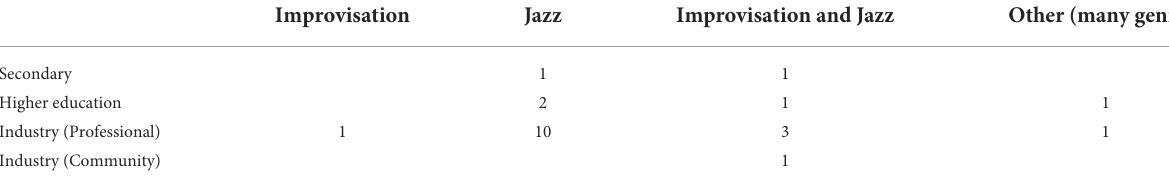
TABLE 2 Geographical distribution of the research.